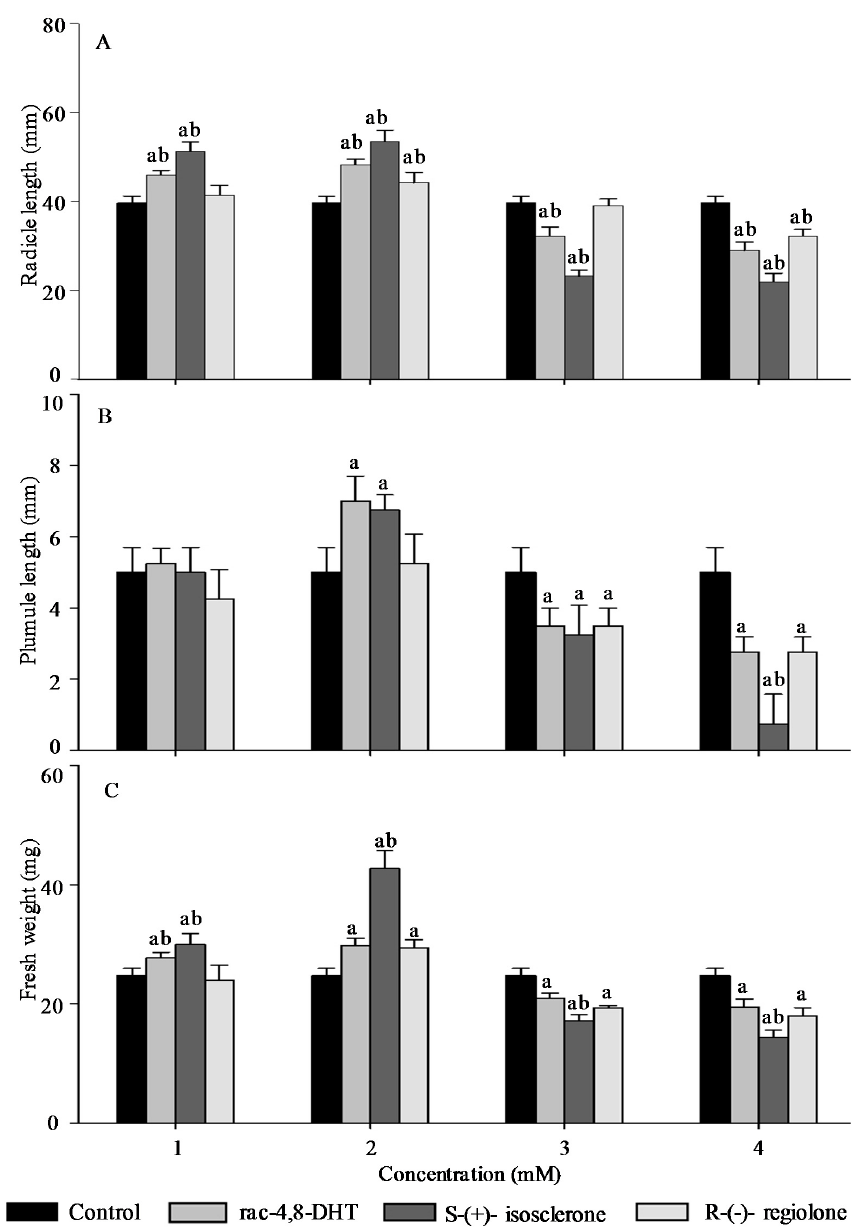
Figure 2. Effect of rac-4,8-DHT, S -(+)-isosclerone, and R -( − )-regiolone at different concentrations on radicle length ( A ); plumule length ( B ); and fresh weight ( C ) in lettuce. a denotes a significant difference between control and treatments ( p < 0.05); b denotes significant difference among rac-4,8-DHT, S -(+)-isosclerone, and R -( − )-regiolone ( p < 0.05).